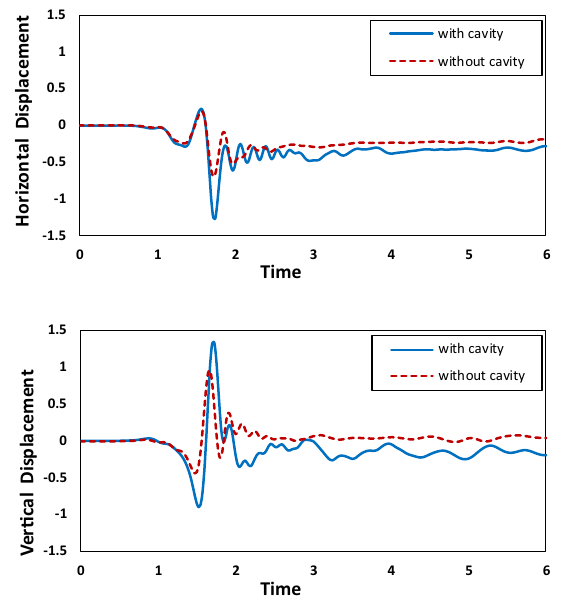
Fig. 7 The horizontal and vertical components of the reference point normalized displacement in two modes with and without the cavity under the R-wave propagation ( x/a = 0, DR = 1.5)